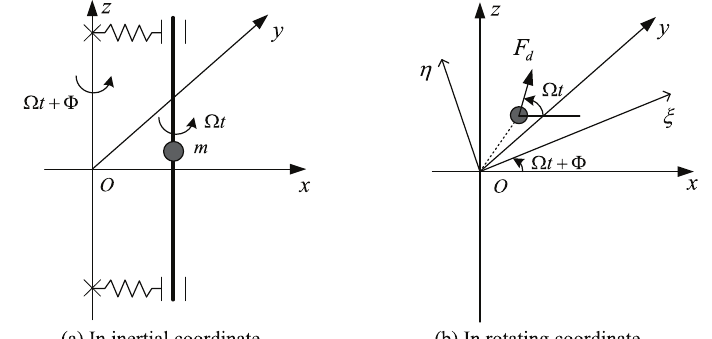
Fig. 4. Jeffcott rotor model.